Question: State the chart type depicted above.
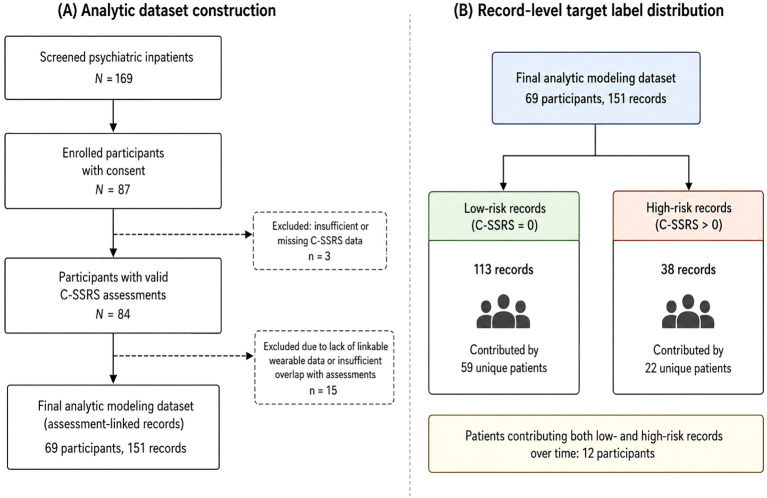
Answer: line